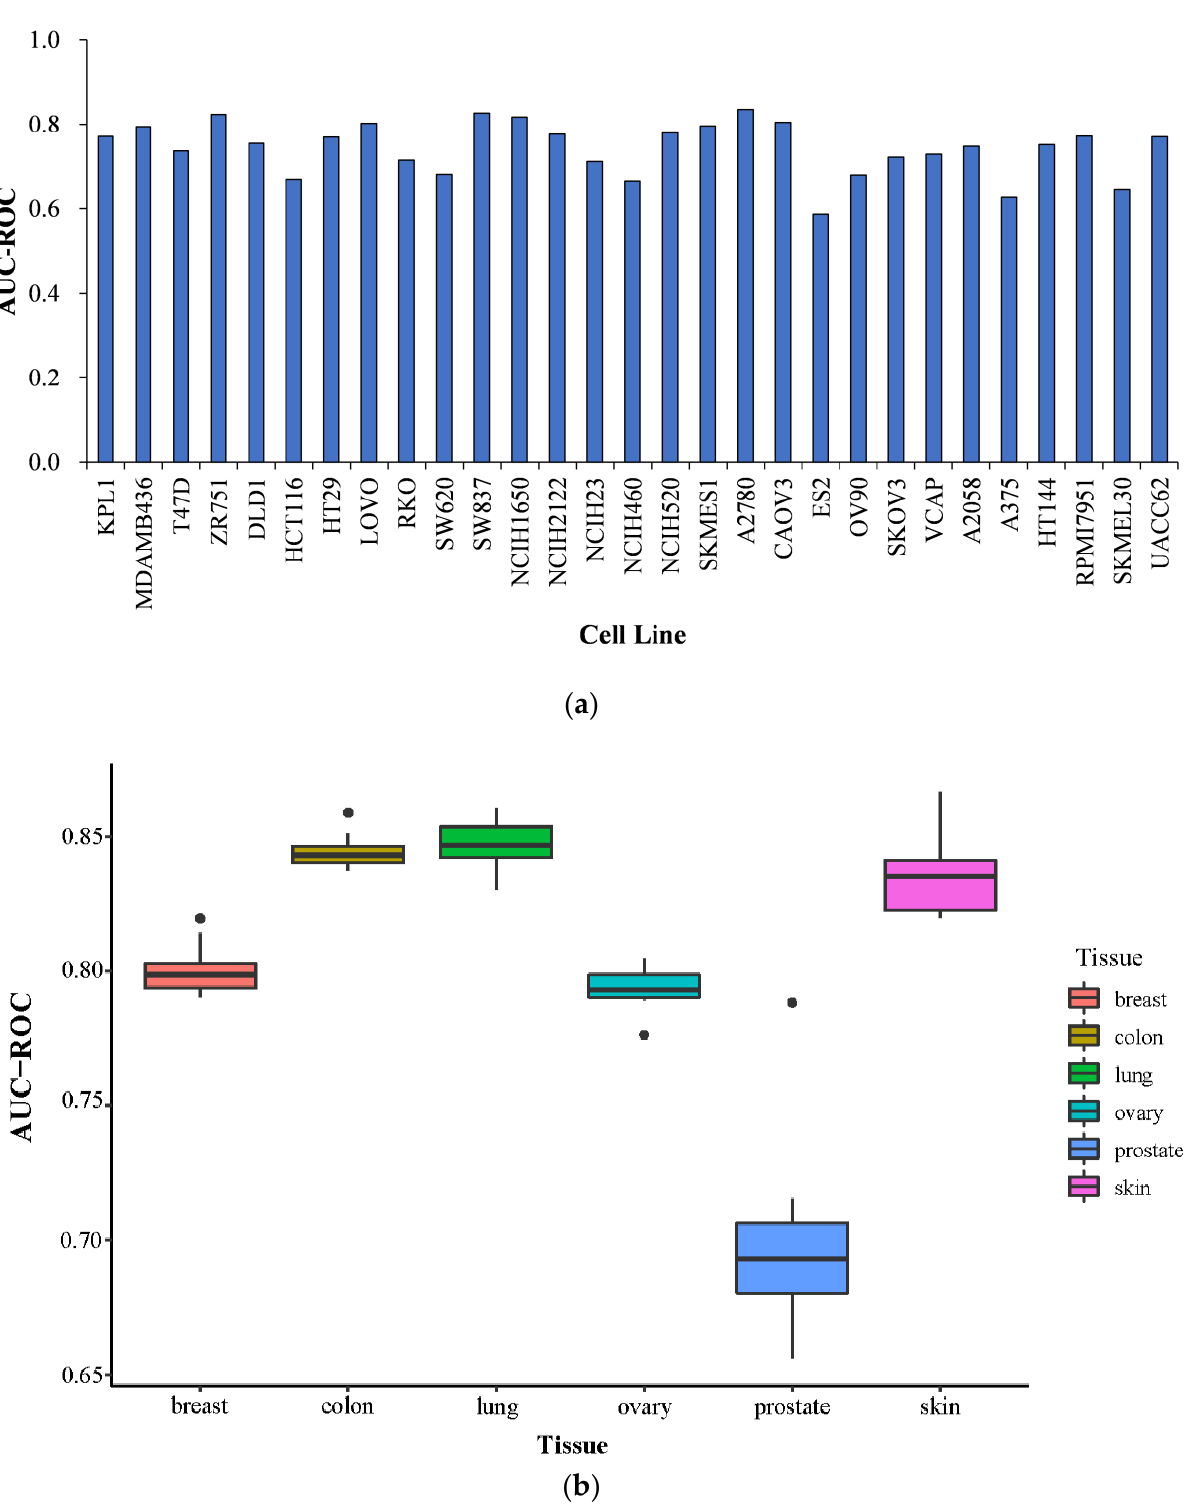
Figure 3. Cell-line-specific and tissue-specific prediction performances of NEXGB. ( a ) Cell-line-specific performance. The average ROC-AUC value in the 29 cell lines is around 0.75, with the highest value of 0.835 for A2780 cell line and the lowest value of 0.587 for ES2 cell line. ( b ) Tissue-specific performance. Among the six types of tissues, the prostate tissue had the lowest performance in general.